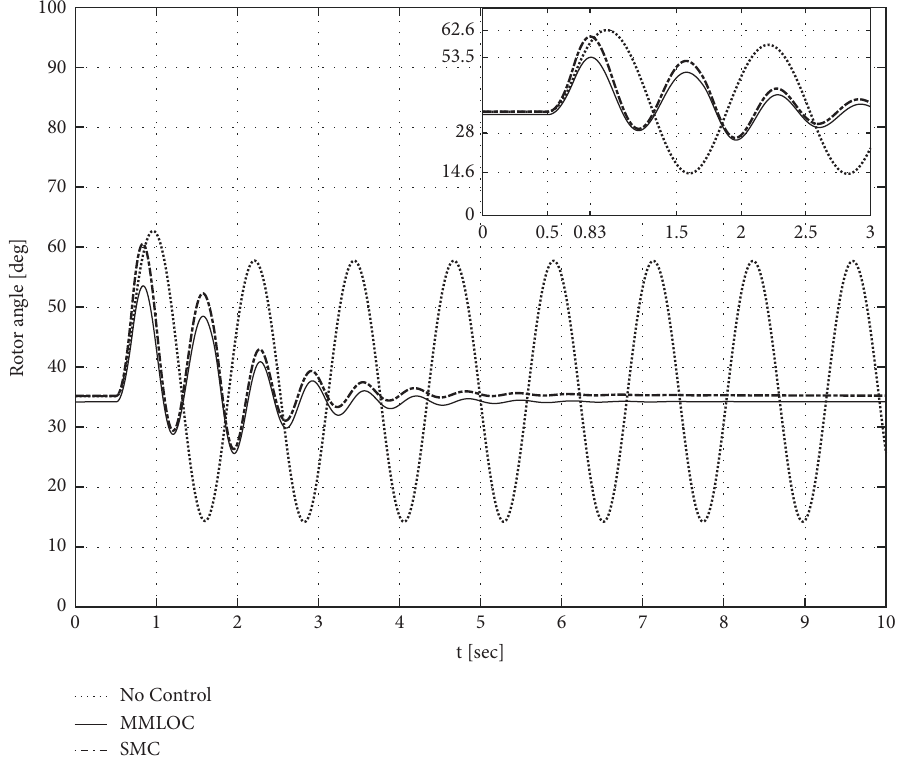
Figure 6: Rotor angle of the generator with MMLOC and SMC and without